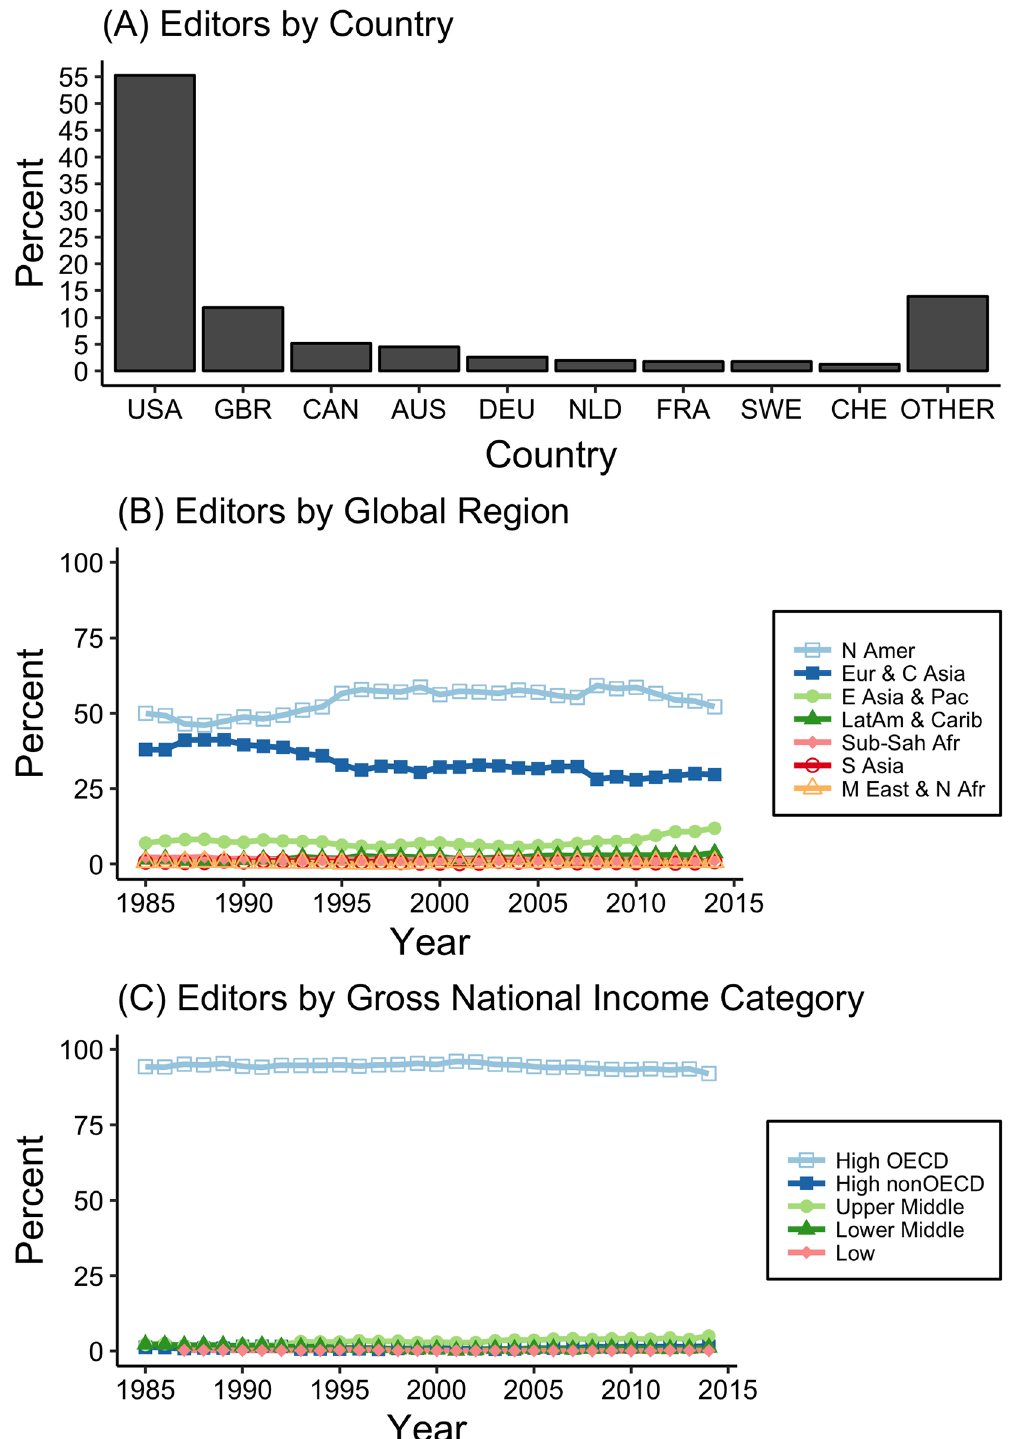
Fig 2. The percentage of environmental biology editors based in different countries, global regions, and World Bank national income categories. (A) Countries.(B) World Bank globalregions. (C) World Bank gross nationalincome categories. The DOIs for the datasets used in this paper (both archivedat Dryad) are https://doi.org/ 10.5061/dryad.6jn86.2and https://doi.org/10.5061/dryad.mh189. AUS, Australia; CAN, Canada;CHE, Switzerland; DEU, Germany; FRA, France; GBR, United Kingdom; NLD, Netherlands; OECD, Organization for Economic Cooperation and Development; SWE, Sweden;USA, United States of America.